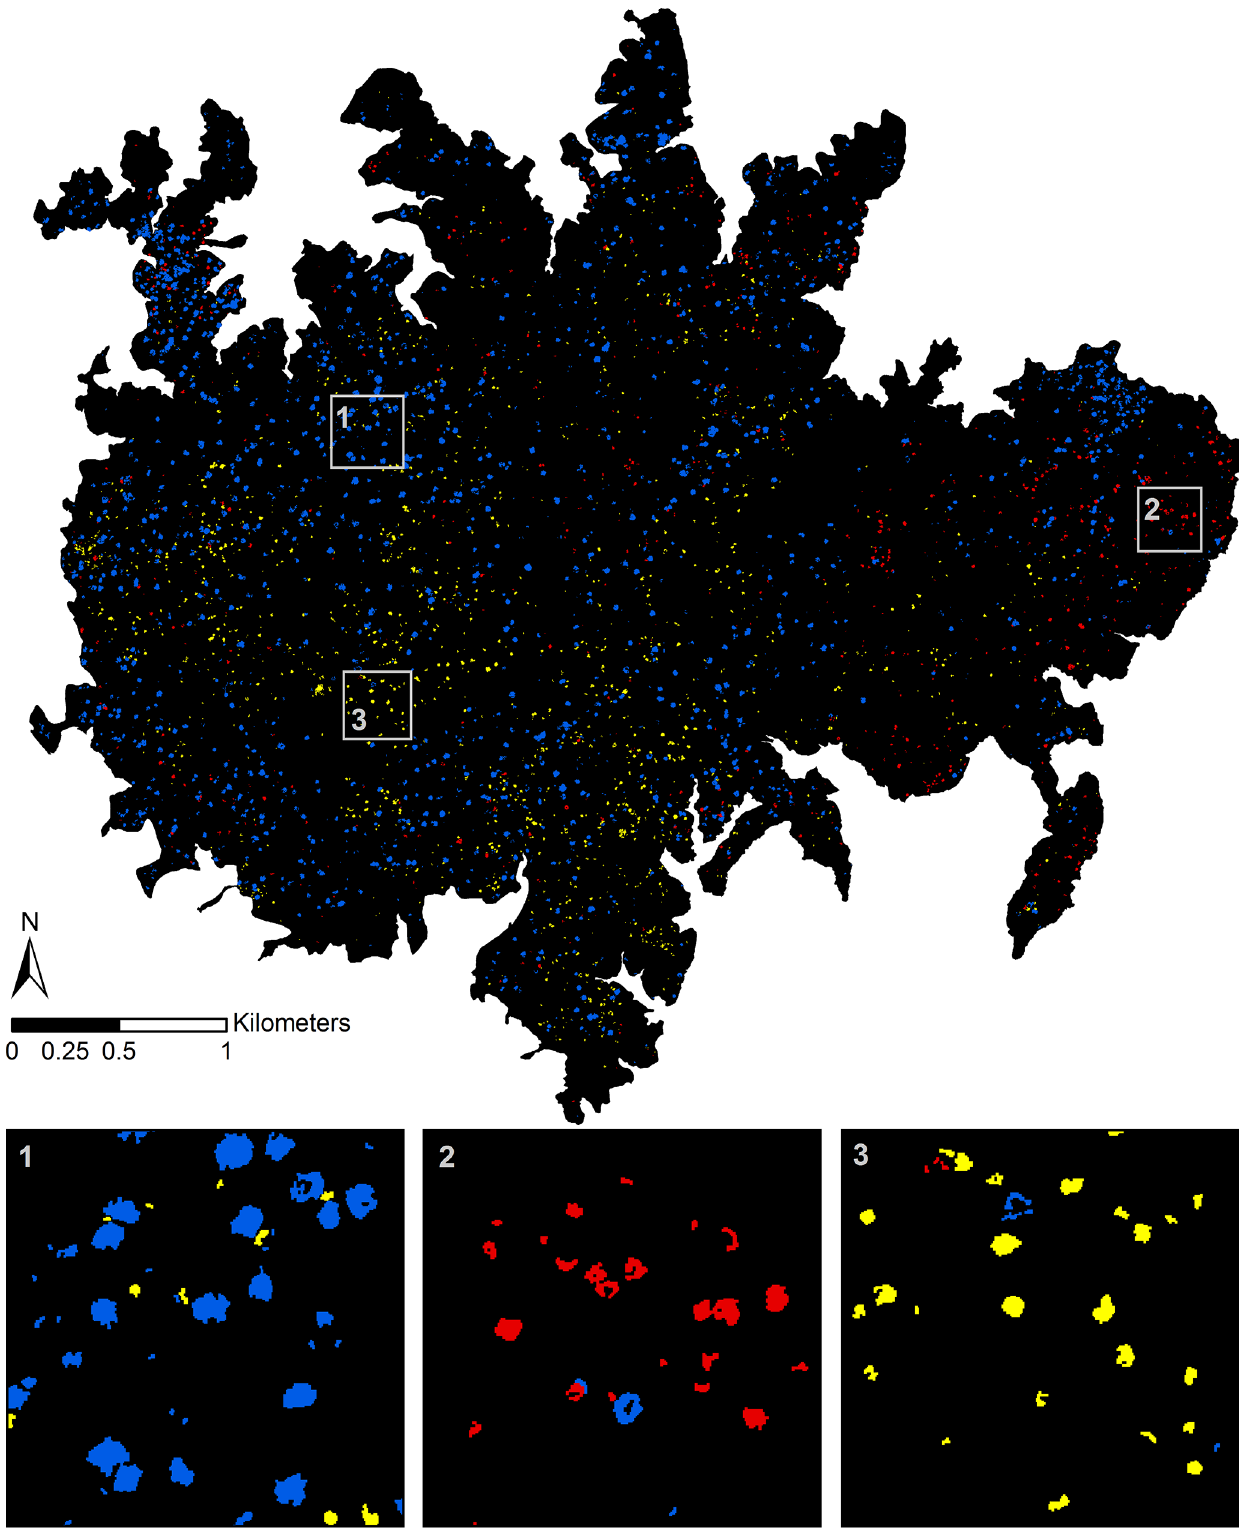
Fig 6. Prediction results for the three focal species across BCI. Blue = D . panamensis , red = H . guayacan , and yellow = J . copaia . Insets show close-up of results for high-density areas of each focal species.